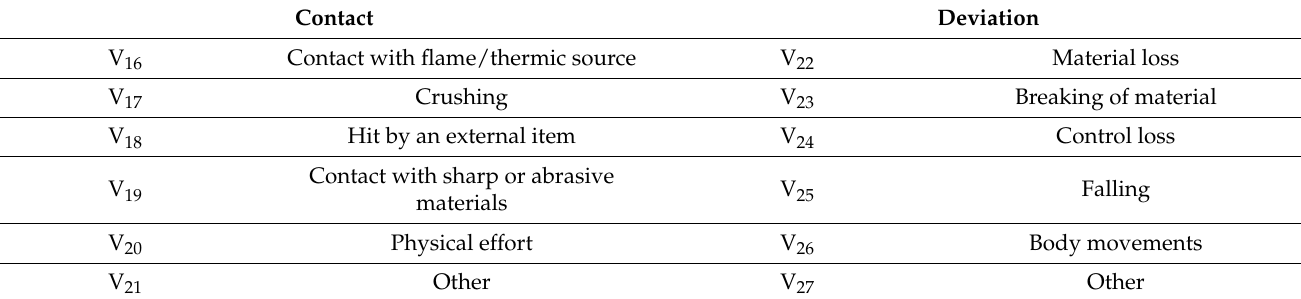
Table 7. Variables related to “Contact” and “Deviation”